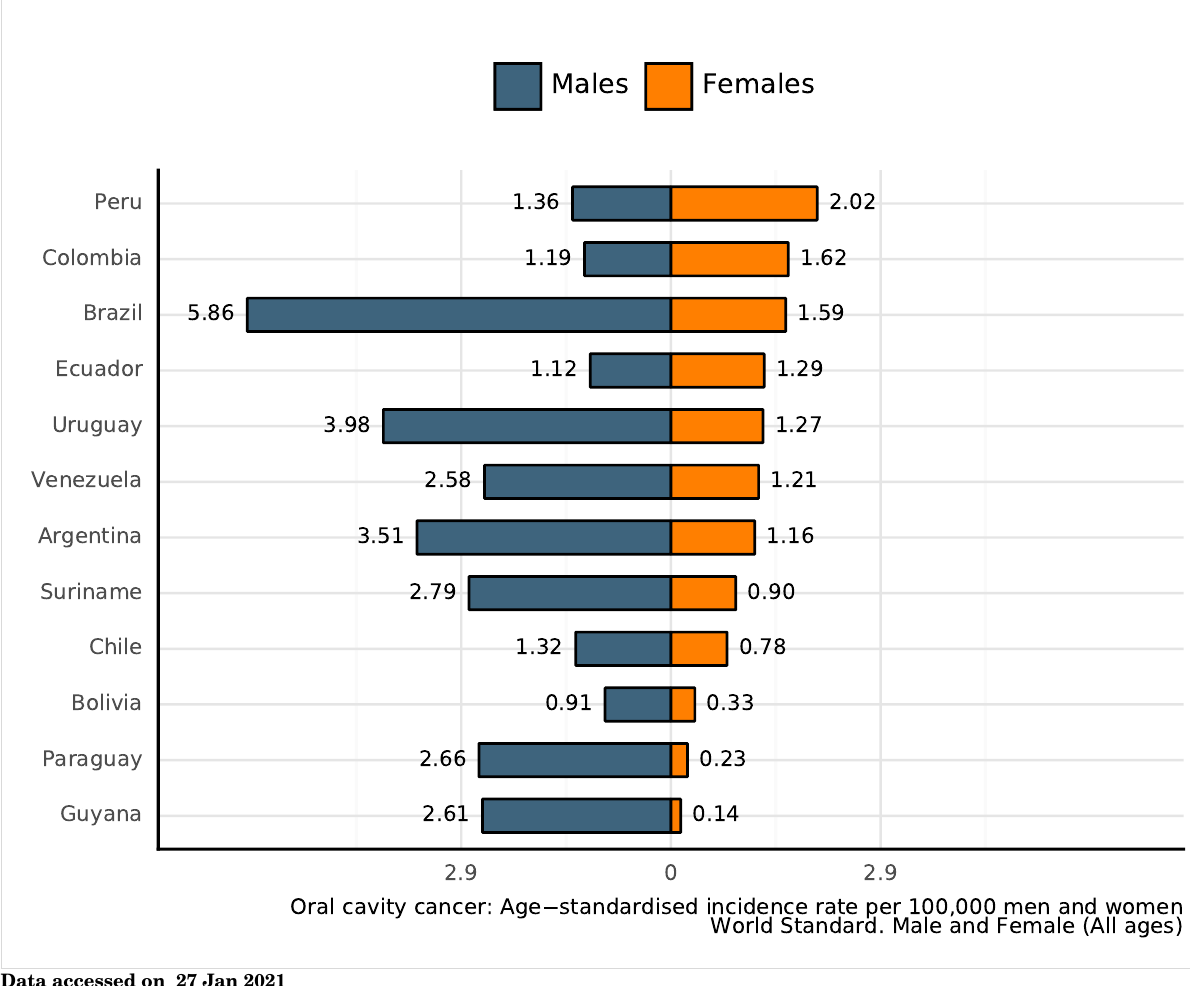
Figure 95: Age-standardised incidence rates of oral cavity cancer of Peru (estimates for 2020)